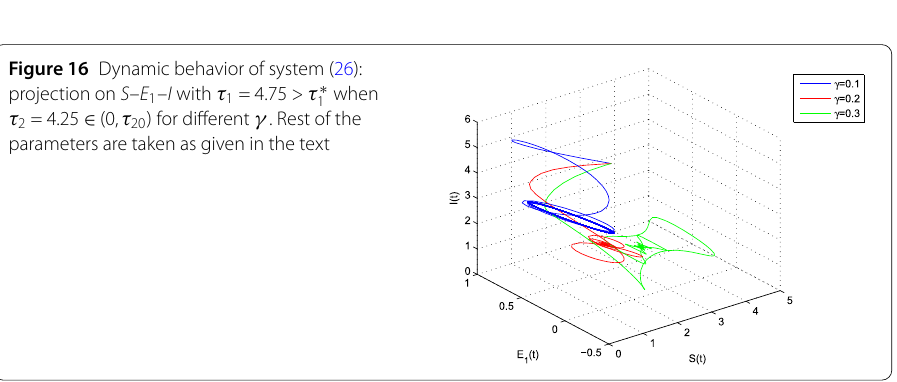
Figure 15 Time plots of S , E 1 , E 2 and I for different γ at τ 1 = 4.05 when τ 2 = 4.25 ∈ (0, τ 20 ). Rest of the parameters are taken as given in the text